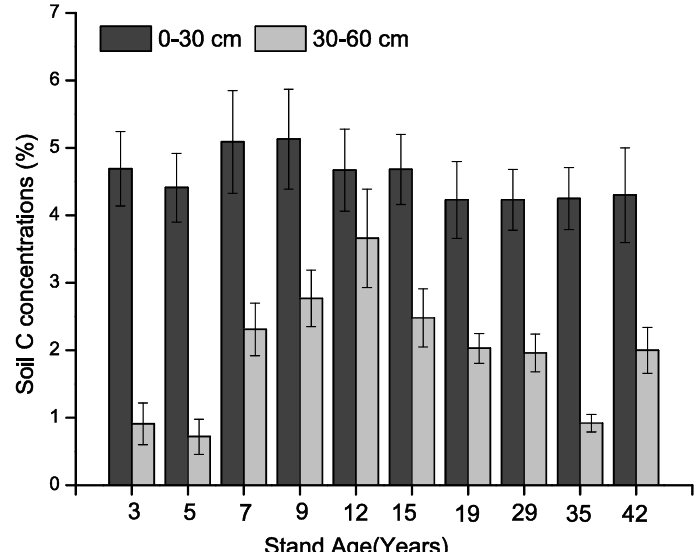
Figure 2. Mineral soil C concentrations in the different sampled soil layers of the different stand ages; values are the means; error bars are the standard deviations, n = 3. Conc = concentration. Table 3. Carbon pool (t·ha −1 ) and its allocations in the Pinus massoniana plantation with different stand ages in Gao County, Sichuan Province.